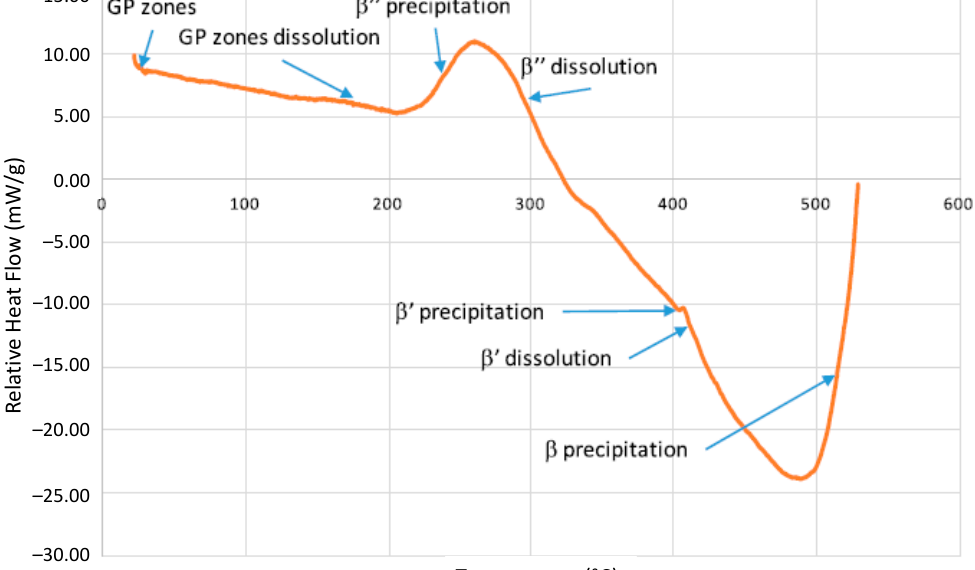
Figure 10. DSC scan for Al 6061.